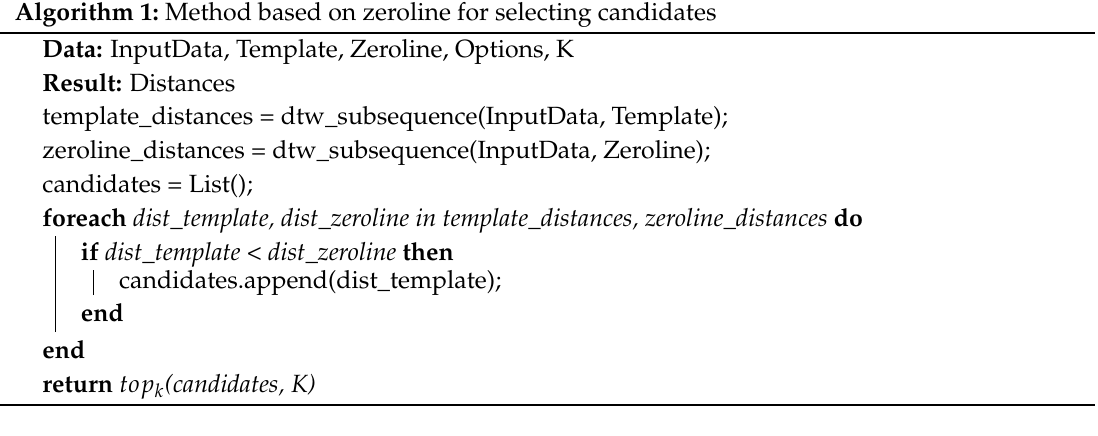
Algorithm 1: Method based on zeroline for selecting candidates